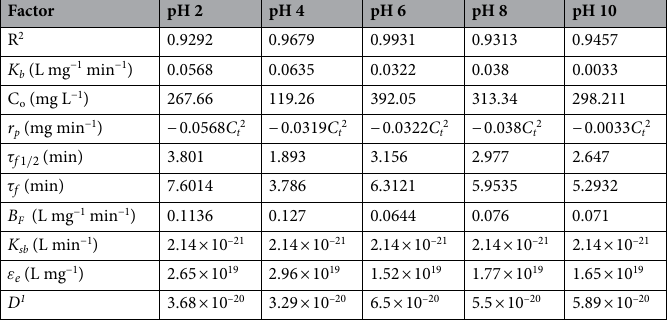
Table 3. CF kinetic parameters at 0.2 g PNSC L −1 and 303 K at α =